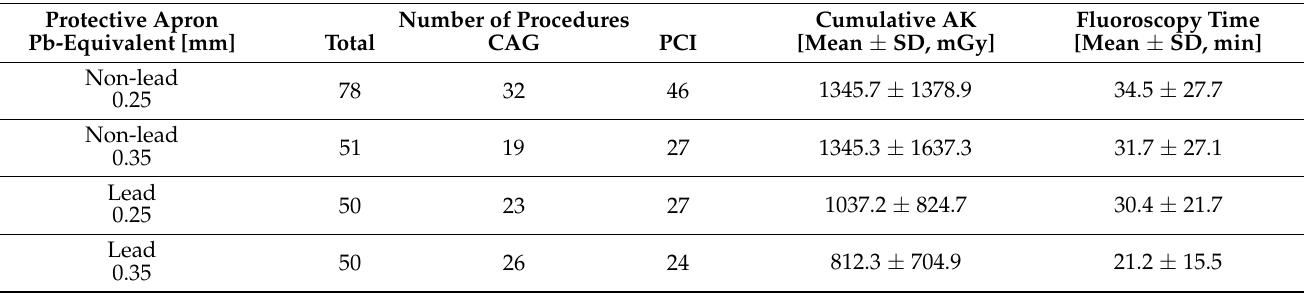
Table 1. A summary of our study.